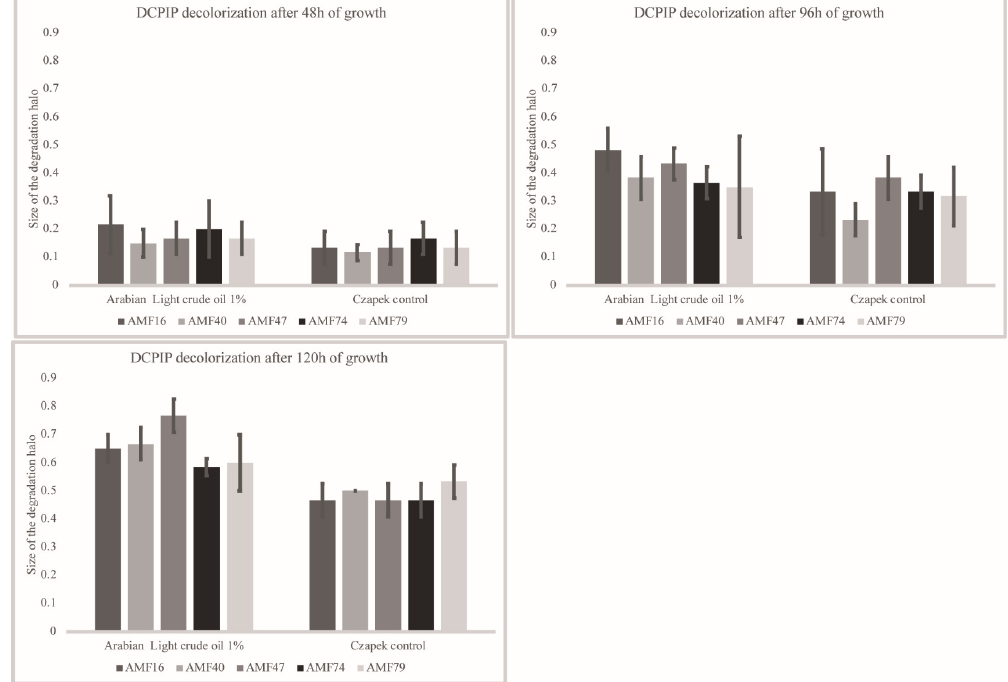
Figure 3. Figure 3. Level of 2,6-dichlorophenol indophenol (DCPIP) discoloration in terms of the average size of a halo around the fungal colonies after 48, 96 and 120 hours of growth ( n = 3). AMF16: Penicillium polonicum ; AMF40: Penicillium cyclopium ; AMF47: Penicillium cyclopium ; AMF74: Penicillium cyclopium and AMF79: Penicillium mononematosum